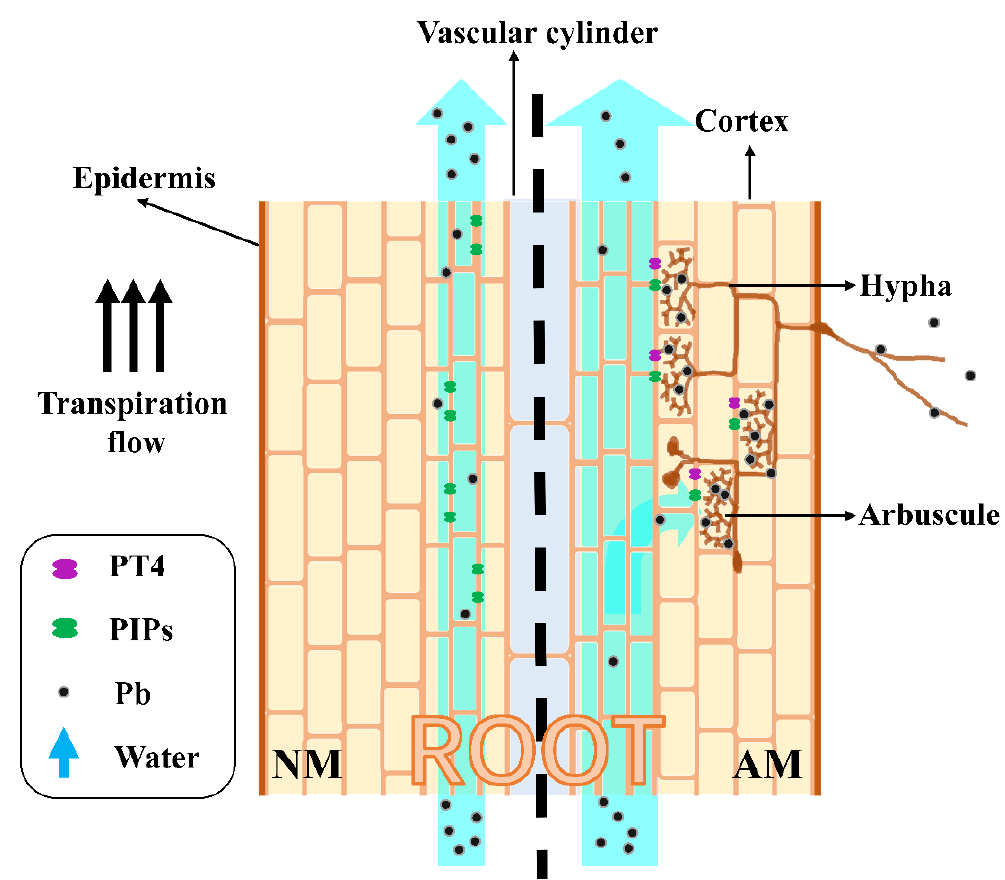
Figure 7. AM fungi can immobilize Pb that R. irregularis in the inoculated compartment as a sifter reduced the content of Pb in a plant.